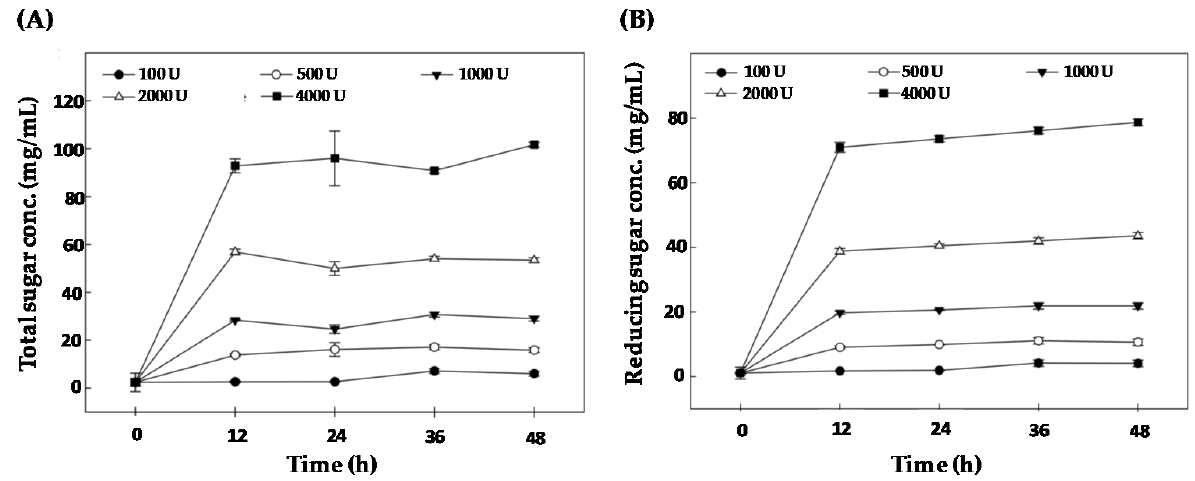
Figure 4. Concentrations of ( A ) total sugar and ( B ) reducing sugar within 2% Porphyra residues hydrolyzed by different cellulase units of commercial cellulase AP3 for 0 to 48 h. * PhLA conc.